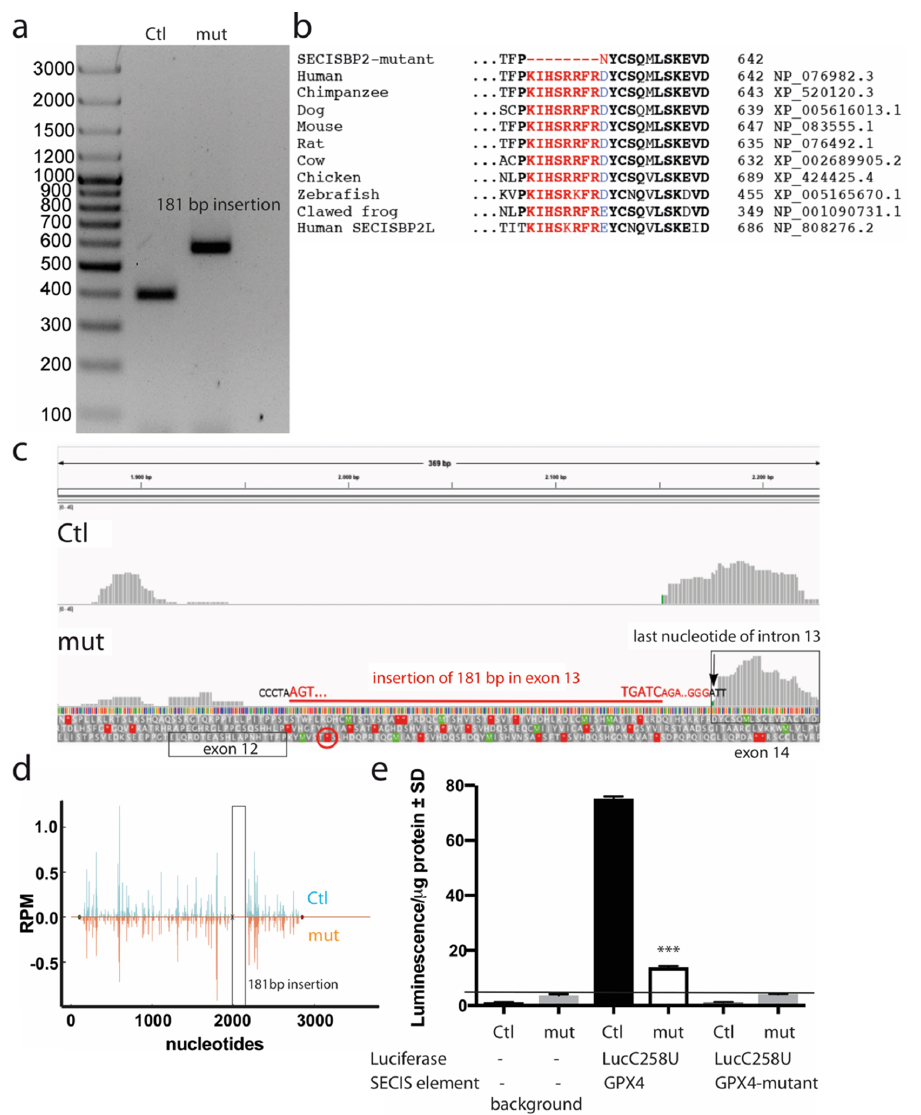
Figure A1. Additional characterization of the mutation in SECISBP2 -mutant HAP1